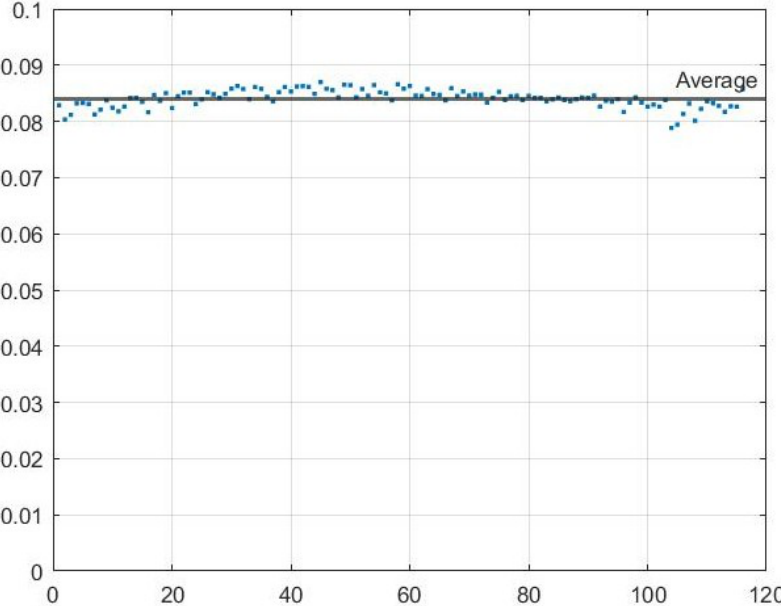
Figure 26. Flow-graph of average delay in seconds of 120 packets transmitted during five trials over the Ethernet connection to the host GNU radio transmitter.